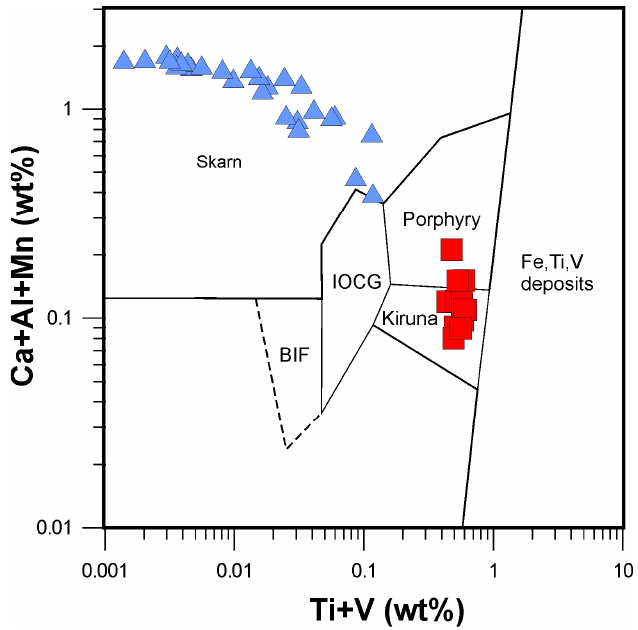
Figure 17. Genetic discrimination diagram of Fe,Ti,Mg ‐ oxides [72] based on Ca+Al+Mn and Ti+V contents in spinels (blue triangles) and ulvöspinel ‐ magnetite series (red squares) from Č amovce xenoliths. Abbreviations: BIF—Banded iron formations, IOCG—Iron oxide copper ‐ gold deposits.